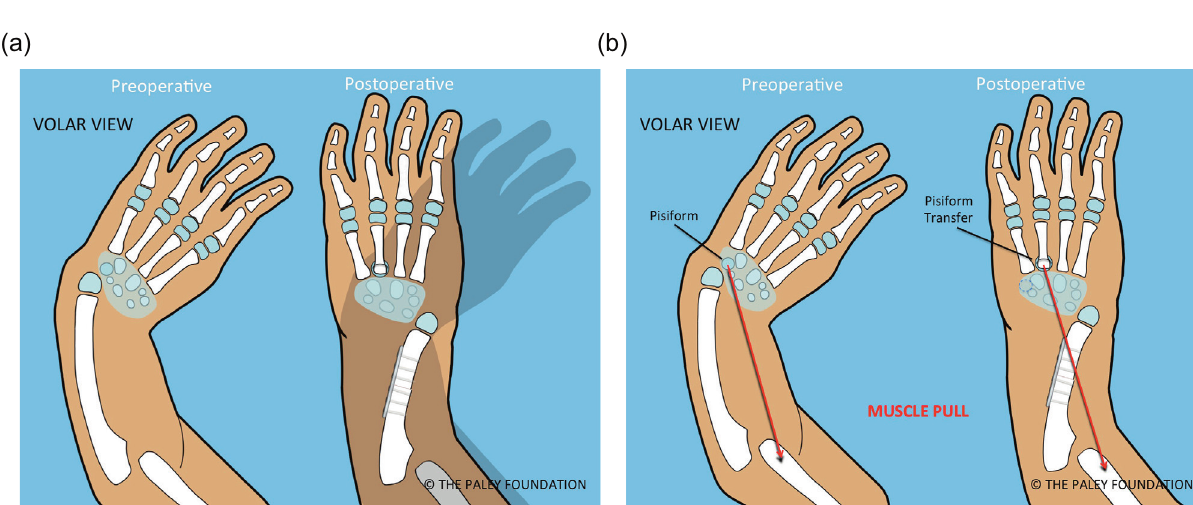
Figure 1. Pre- versus postoperative position of the hand following ulnarization with shortening (a). The muscle forces before surgery pull the hand into more radial deviation while after surgery there is a balance of forces with the ulnar head acting as a bony block to radial deviation (b).